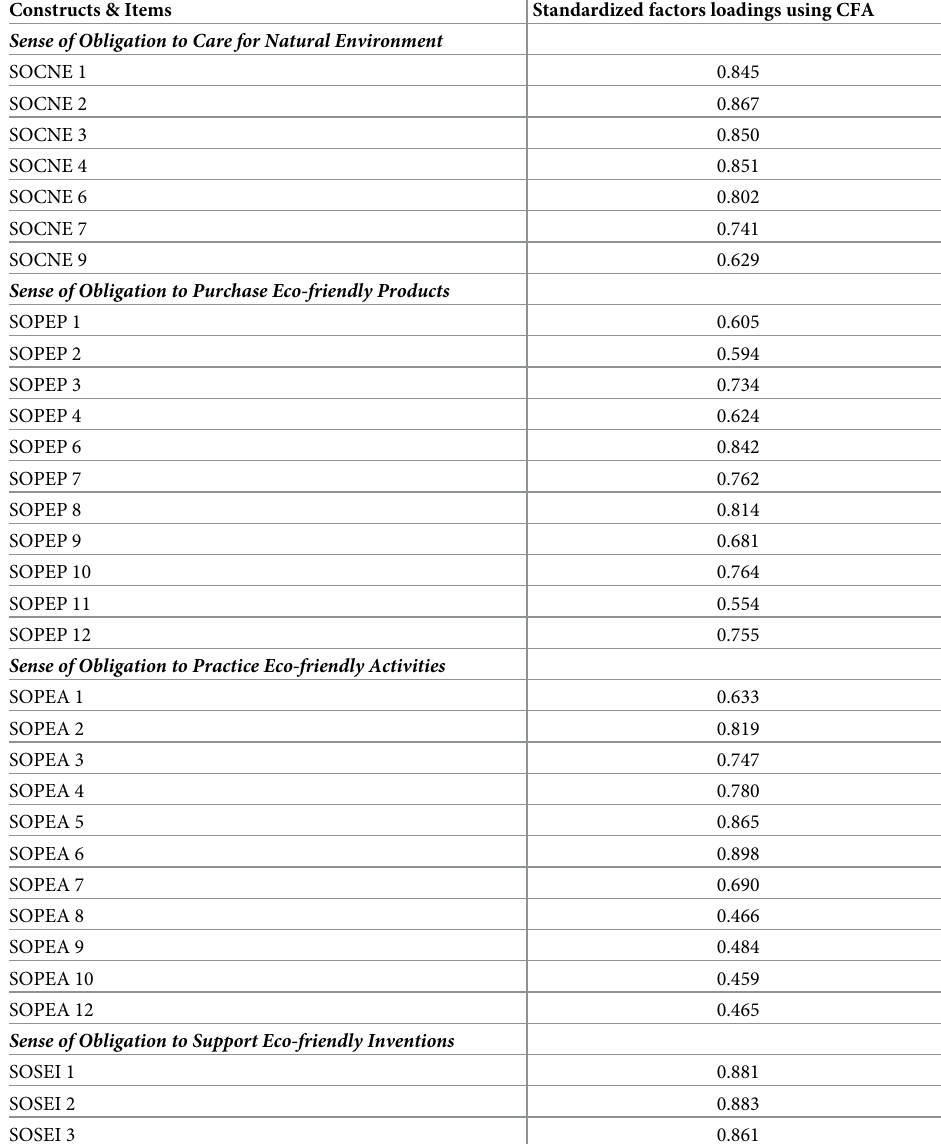
Table 5. Factor loadings of confirmatory factory analysis (N = 268).